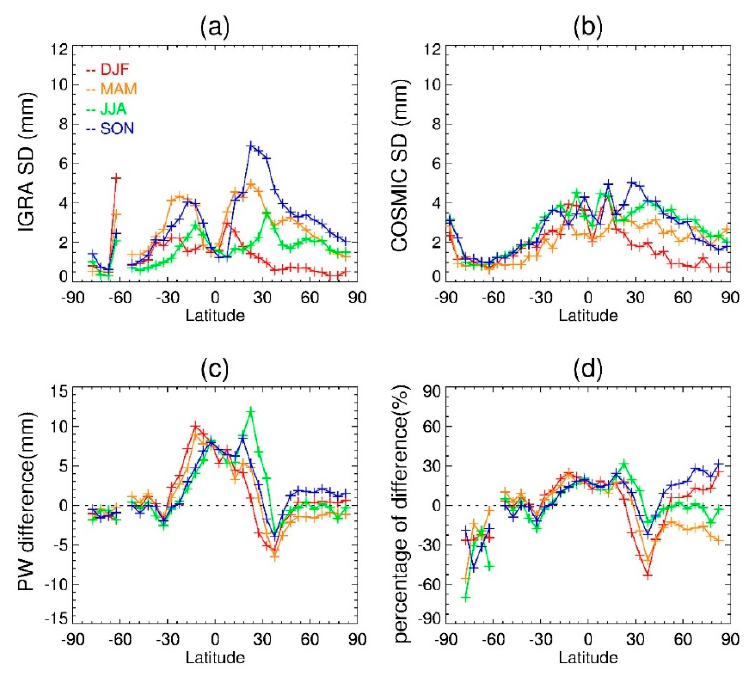
Figure 6. ( a ) One standard deviation of the seasonal PW in latitudes of IGRA data; ( b ) one standard deviation of the seasonal PW in latitudes of COSMIC data; ( c ) latitudinal variation of differences between IGRA and COSMIC (difference = IGRA PW − COSMIC PW); ( d ) latitudinal variation of percentage of PW differences between IGRA and COSMIC (percentage = difference/(IGRA PW + COSMIC PW)/2).